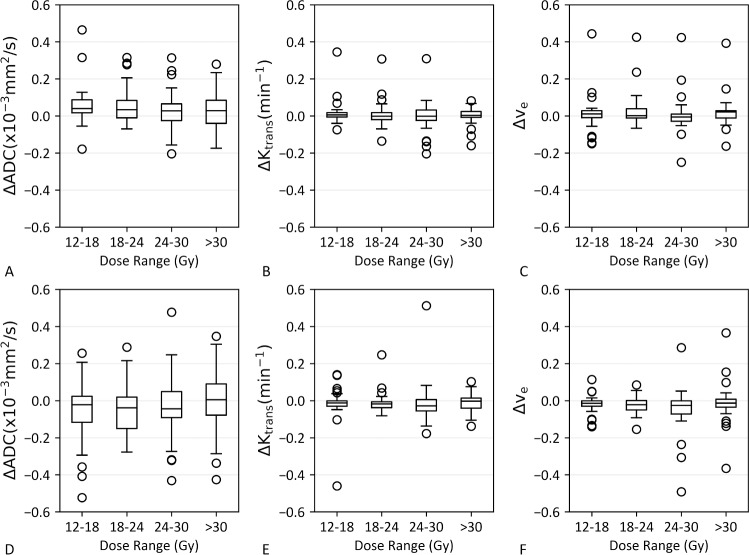
Mean ΔADC, ΔKtrans and Δve values for various dose ranges within the GTV at day 3 (A—C), and day 20 (D–F).